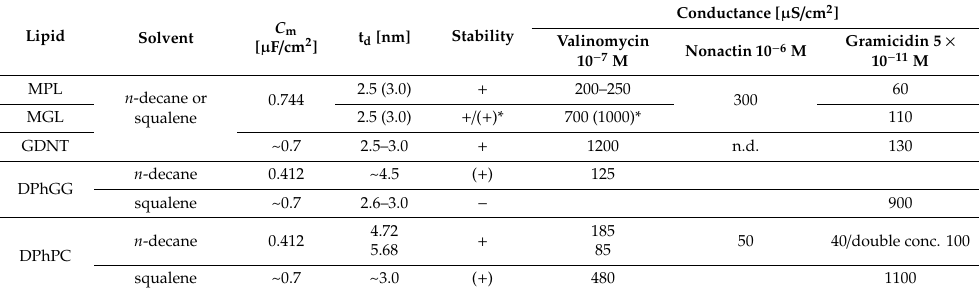
processing are larger, in µ-meter range (Figure 5). Zeta potential of − 58.2 mV was determined from